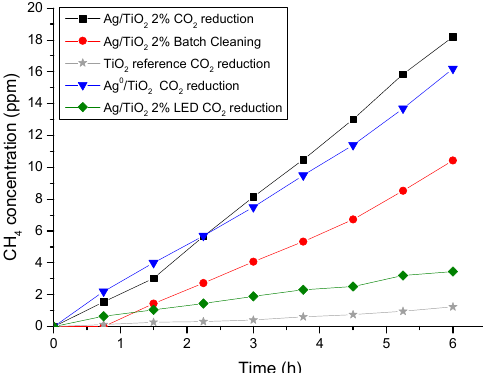
Figure 7. CH 4 concentration over time for the Ag/TiO 2 2% sample in batch cleaning, and CO 2 reduction with Hg/Xe lamp and LED, as well as CO 2 reduction with metallic state Ag 0 /TiO 2 2%. Bare TiO 2 is used as a reference.